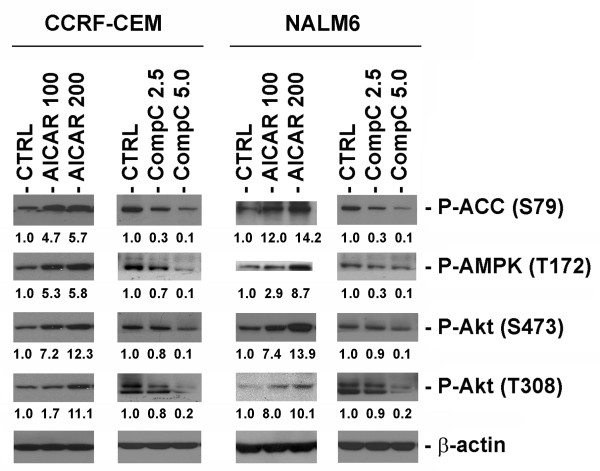
Functional AMPK activity is required for activation of Akt at Ser473 and Thr308 in ALL cell lines. CCRF-CEM and NALM6 cells were exposed to either the AMPK activator AICAR (100 and 200 μM) or the AMPK inhibitor compound-C (CompC, 2.5 and 5.0 μM) for 24 h at 37°C. Proteins were extracted and analyzed by Western immunoblotting for the expression of P-Akt (Ser473 and Thr308), P-AMPK (Thr172), and P-ACC (Ser79). The density value of each band was normalized to β-actin level and expressed relative to control (shown as fold induction).